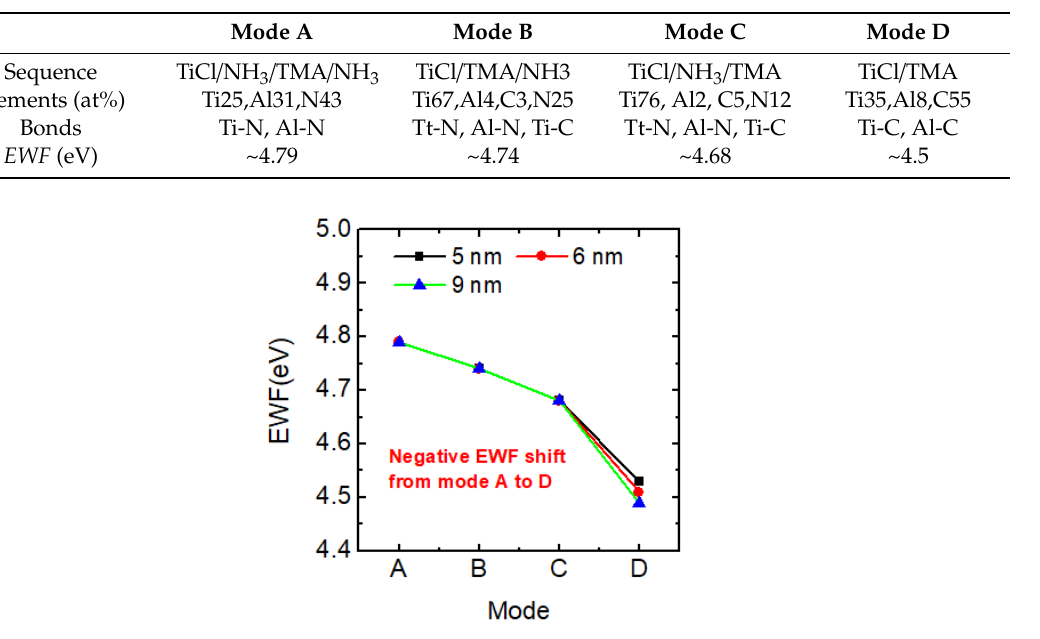
Figure 10. EWF comparison between the ALD TiAlN and TiAlC.